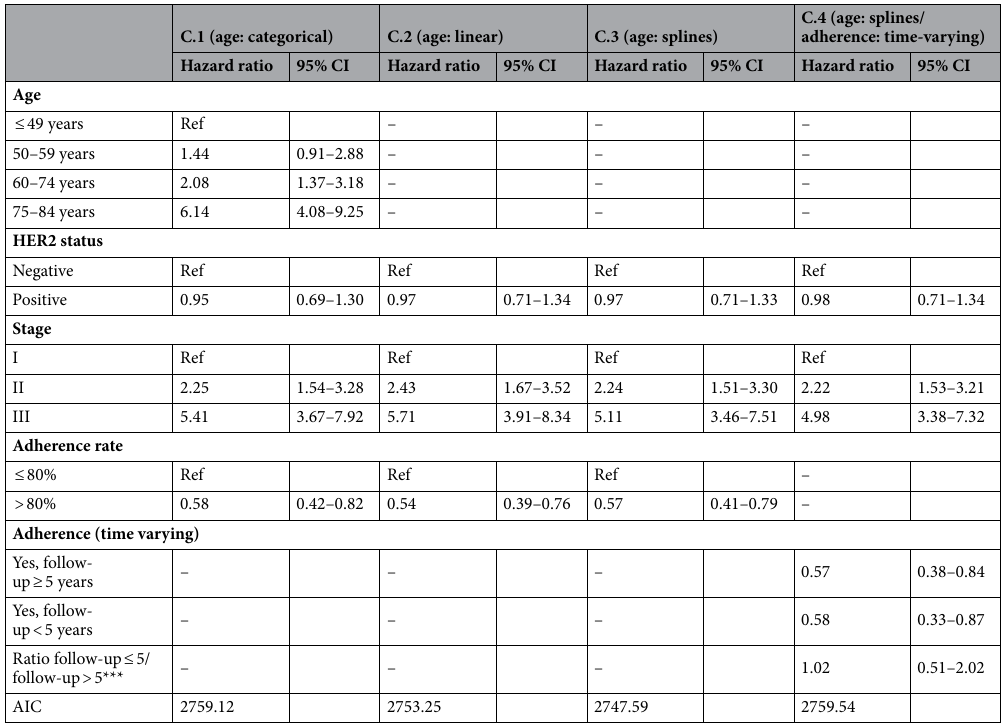
Table 2. Hazard ratios derived from the four predictive models fitted: model C.1 considers age as categorical variable; model C.2 considers age as linear continuous variable; model C.3 considers restricted cubic splines on age; model C.4 considers restricted cubic splines on age and adherence as time varying. CI confidence interval, AIC Akaike Information Criterion, *: Beta coefficient for adherence was considered as time varying coefficient. **: hazard ratio for adherence for patients with follow-up > 5 years; *** Ratio of the hazard rates of the variable adherence = “Yes” for patients with follow-up ≤ 5 years versus > 5